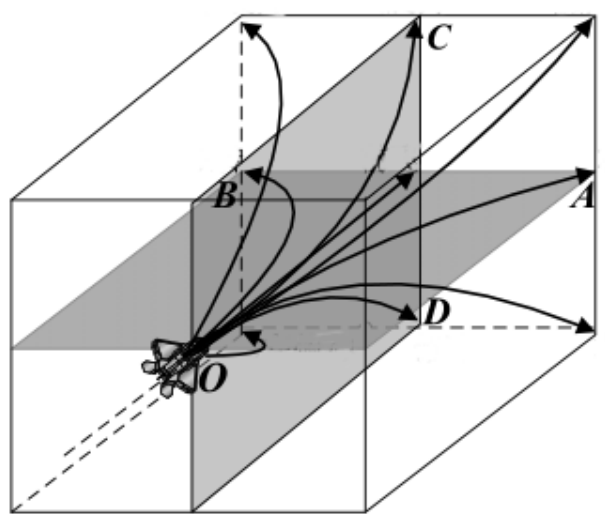
Figure 6. Maneuver direction schematic.